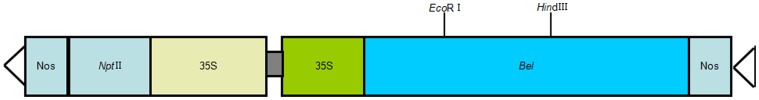
Schematic diagram of T-DNA incorporating the Bel expression cassette and the npt II selective marker gene.